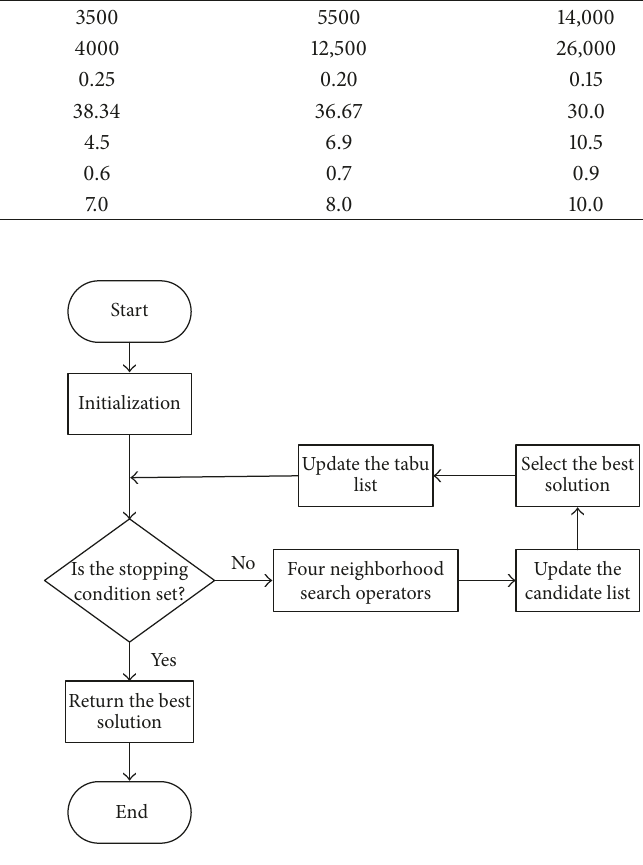
Figure 2: The flowchart of our algorithm.